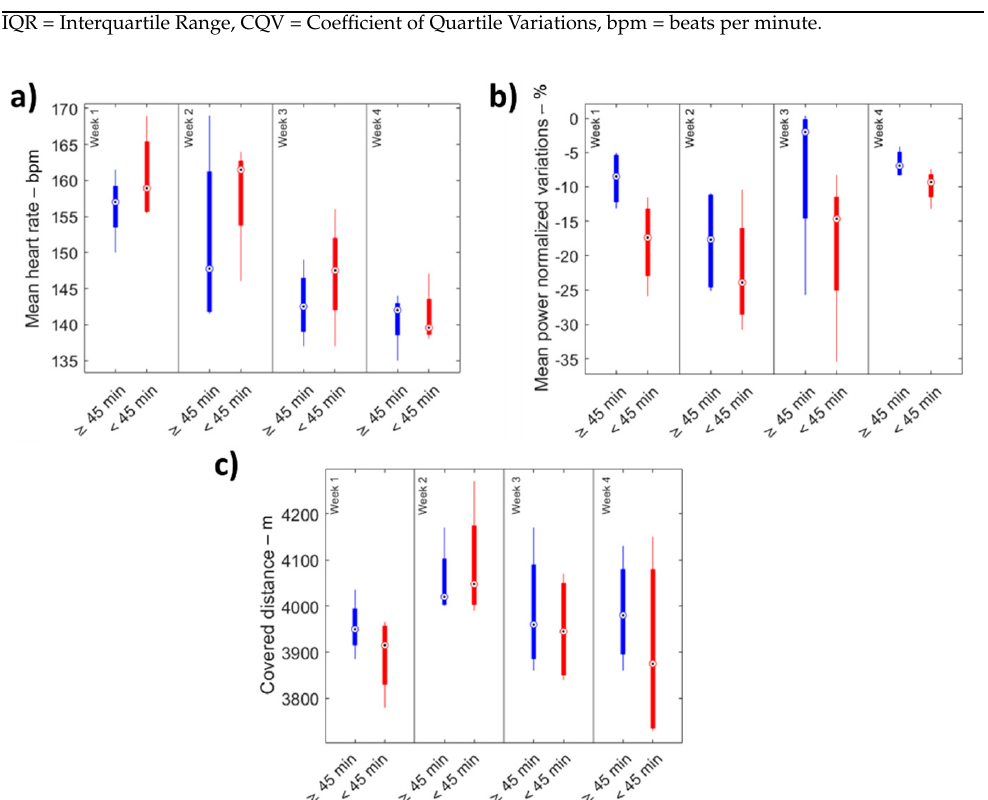
Figure 2. Boxplots and Bonferroni’s comparison for: ( a ) covered distance, ( b ) mean heart rate, ( c ) Wingate’s mean power and minimum power. Dashed lines indicate an incresead median performance, while solid lines indicate a decreased one.